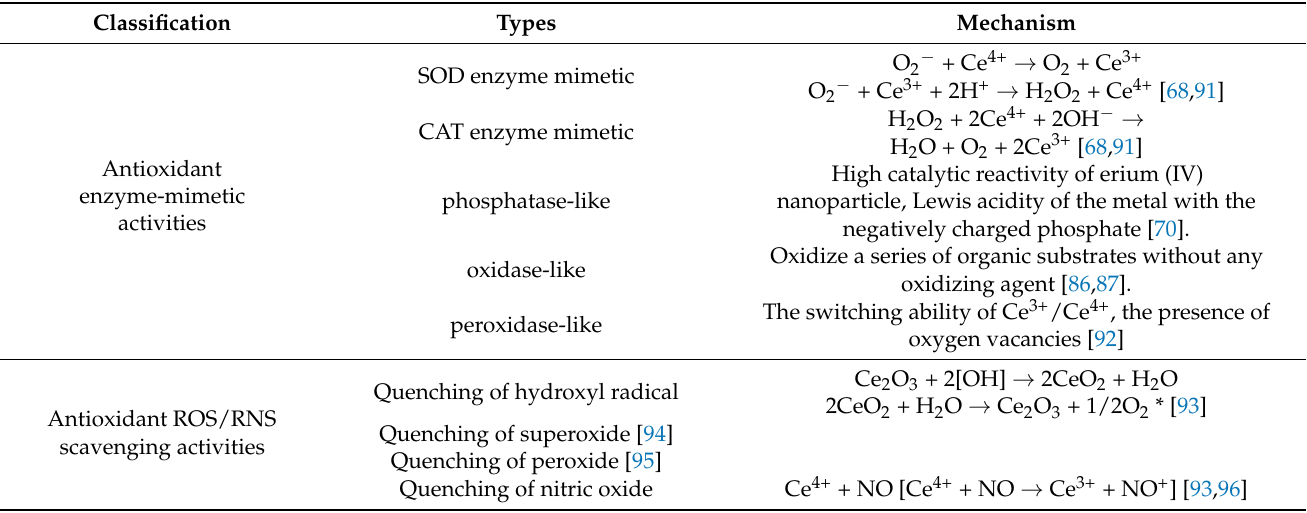
Table 1. The mechanism of the cerium